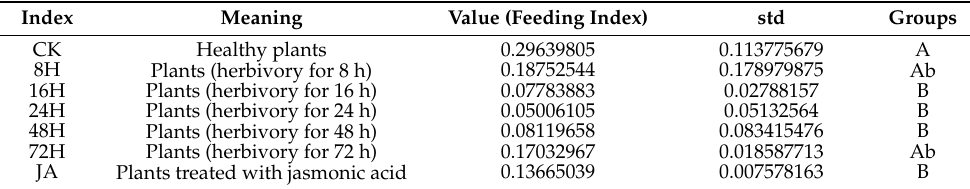
Table 1. Summary of insect feeding performance on plants. The statistical approach was the LSD test. The herbivory insect is M . usitatus , and the plant is V. unguita ; 20 insects were placed on the surface of the leaf in each treatment group. The feeding index means the number of pest gathered on each leaf group/total number of